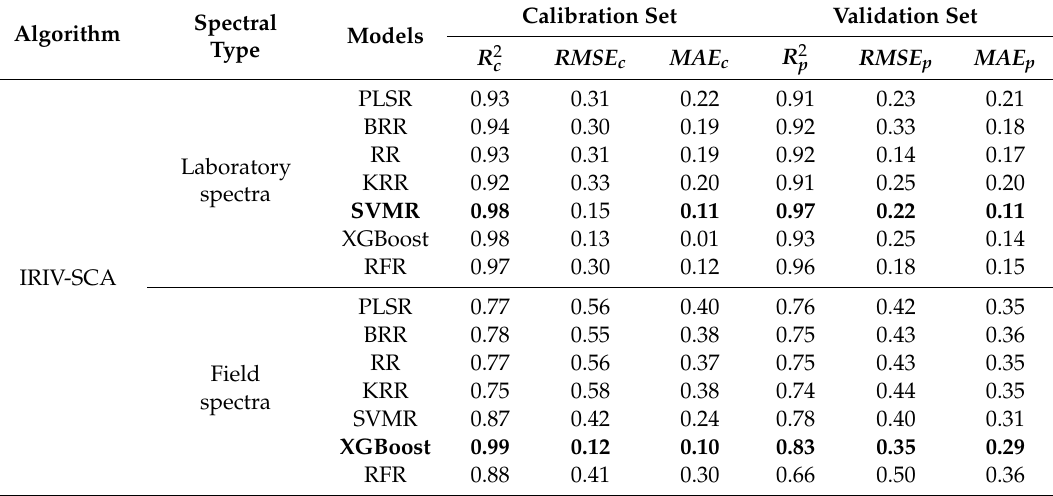
Table 5. Prediction accuracies of the As concentration obtained using laboratory spectra and field spectra based on